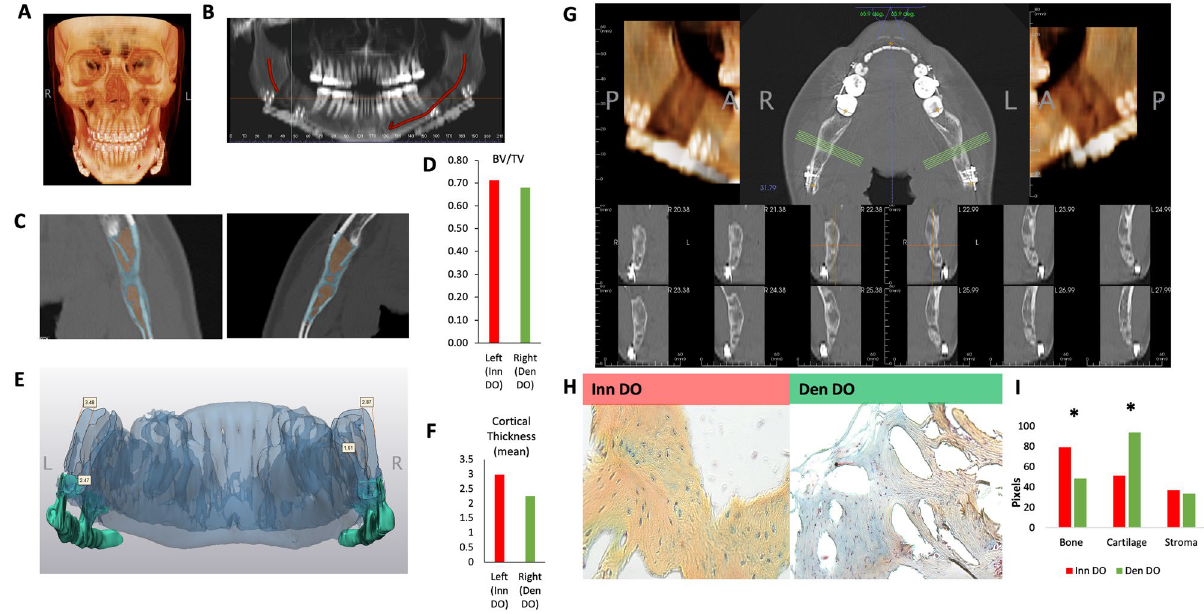
Figure 4. Reduced Bone Density Post Bilateral Mandibular DO Evident in Hemi-mandible of a Patient with IAN Injury Relative to Hemi-mandible with Intact IAN. ( A ) Coronal image of Panorex CT of 13 year old female prior to distractor removal at 3 months post-distraction. ( B ) Representative image of clinical status and course of IAN coursing through mandible at 3 months post distraction. Right: IAN clinically absent, Left: IAN clinically intact. ( C ) (Left) Antero-posterior image of mandible at site of distraction in left hemi-mandible with clinically intact IAN at 3 months post distraction. (Right) Antero-posterior image of mandible at site of distraction in right hemi-mandible with clinically absent IAN at 3 months post distraction. ( D ) Graph demonstrating analysis of bone regenerate callus mineralized volume fraction (bone volume/total tissue volume, or BV/TV) of Inn DO (red) versus Den DO (green) as determined by CT histomorphometry. ( E ) 3D reconstruction of mandible (oriented to illustrate the lingual mandible) at 3 months post distraction demonstrating cortical thickness as determined by CT analysis. ( F ) Graph demonstrating mean cortical thickness of distraction regenerate of Inn DO (red) versus Den DO (green) as determined by CT analysis. ( G ) (Above) Left: Reconstructed CT image demonstrating bone distraction regenerate on denervated side, Middle: Axial image of distracted mandible with green lines representing multiple sites of analysis, Right: Reconstructed CT image demonstrating bone distraction regenerate on innervated side. (Bottom): Multiple representative coronal slices of right (left 3 images top and bottom) Den DO vs left Inn DO (right 3 images above and below) distraction regenerate mandible at 3 months post-distraction. ( H ) Movat’s pentachrome stained representative sections of Inn DO (red) vs Den DO (green) mandible at 3 months post-distraction. Here, yellow denotes bone formation, blue denotes cartilage formation, purple denotes fibrous stroma formation. ( I ) Graph demonstrating composition of human distraction regenerate (bone, cartilage or fibrous stroma). There is significantly greater bone present in Inn DO (red) relative to Den DO (green) (*p < 0.05) and significantly greater cartilage present in Den DO relative to Inn DO (*p <